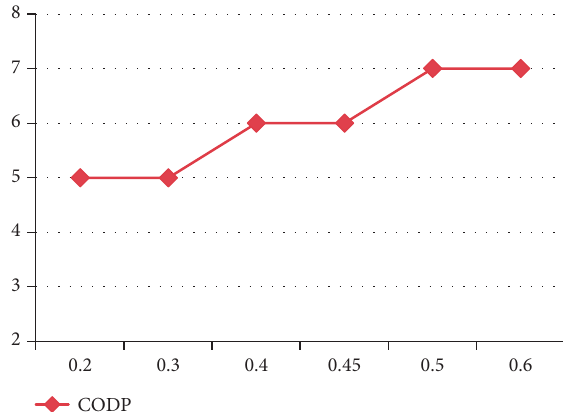
Figure 13: The optimal CODP when different β values are taken under price strategy 2.